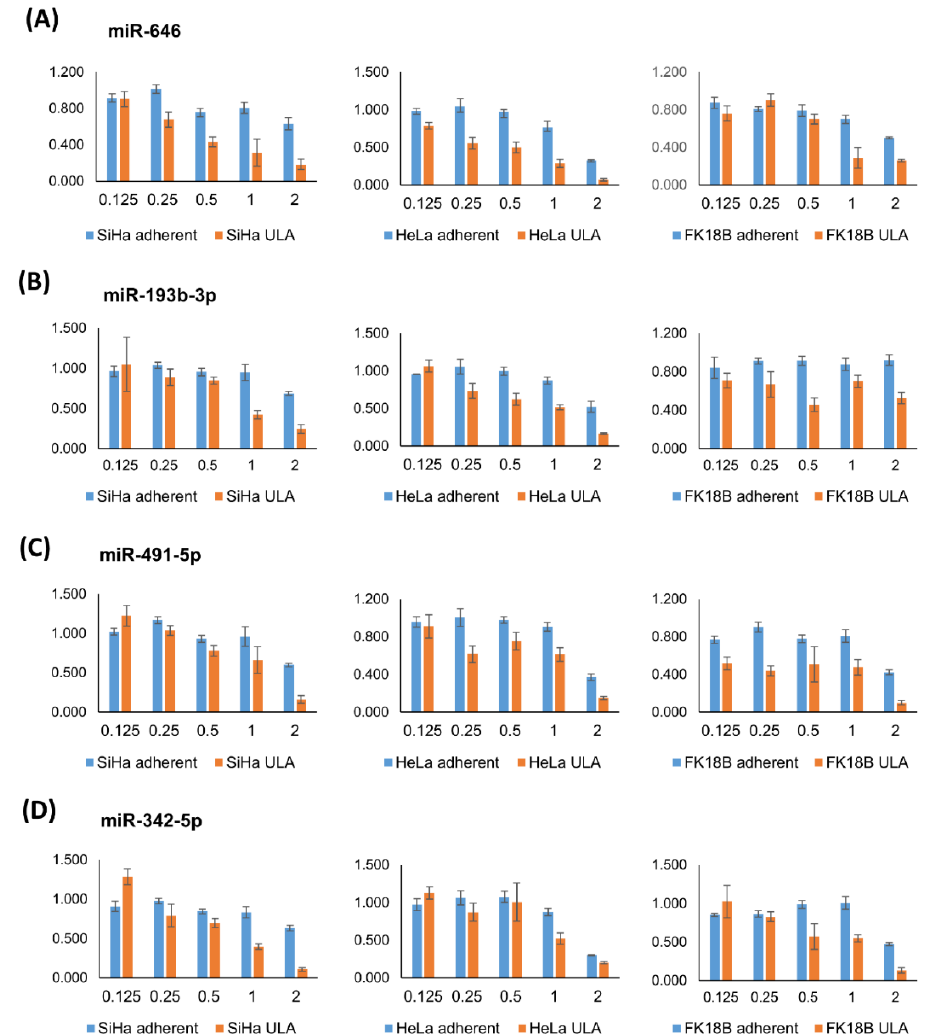
Figure 5. Dose-dependent effect of miRNA mimic transfection. SiHa, HeLa and FK18B cells were transfected with 1, 0.5, 0.25 and 0.125 nM of miR-646 ( A ), miR-193-3p ( B ), miR-491 ( C ) and miR-342-5p ( D ). The values represent normalized cell viabilities relative to negative control C2, in adherent (blue) and ULA (orange) plates. The values of the validation screen using 2 nM concentrations are also shown as a reference. The error bars represent the standard error of two measurements.